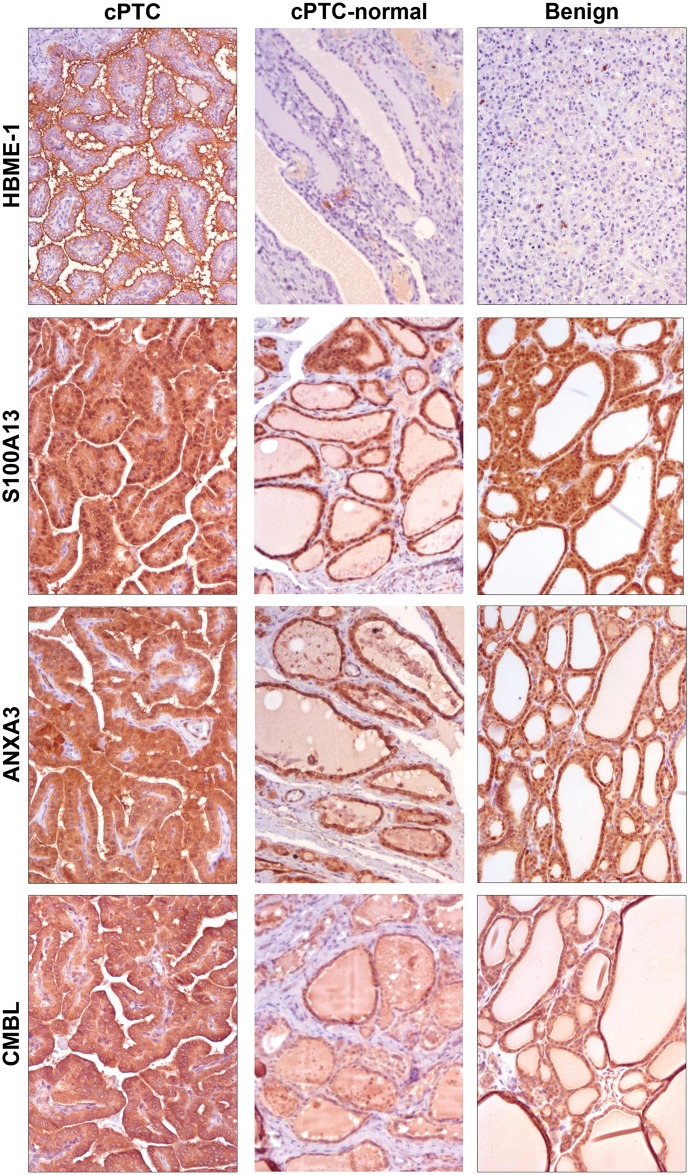
Detection of protein expressions by immunohistochemistry.Expression of HBME-1, S100A13, ANXA3, and CMBL showed in cPTC (left), normal thyroid (middle), and benign thyroid lesions (right) (magnification x60). Up-regulation of HBME-1 in 100% of cPTC cells as compared to accompanying normal thyroid cells is shown together with negative immunoexpression of HBME-1 in a follicular thyroid adenoma. Microphotographs demonstrate moderate-to-strong expressions of S100A13, ANXA3, and CMBL in cPTC, surrounding normal thyroid cell and in colloid goiter.